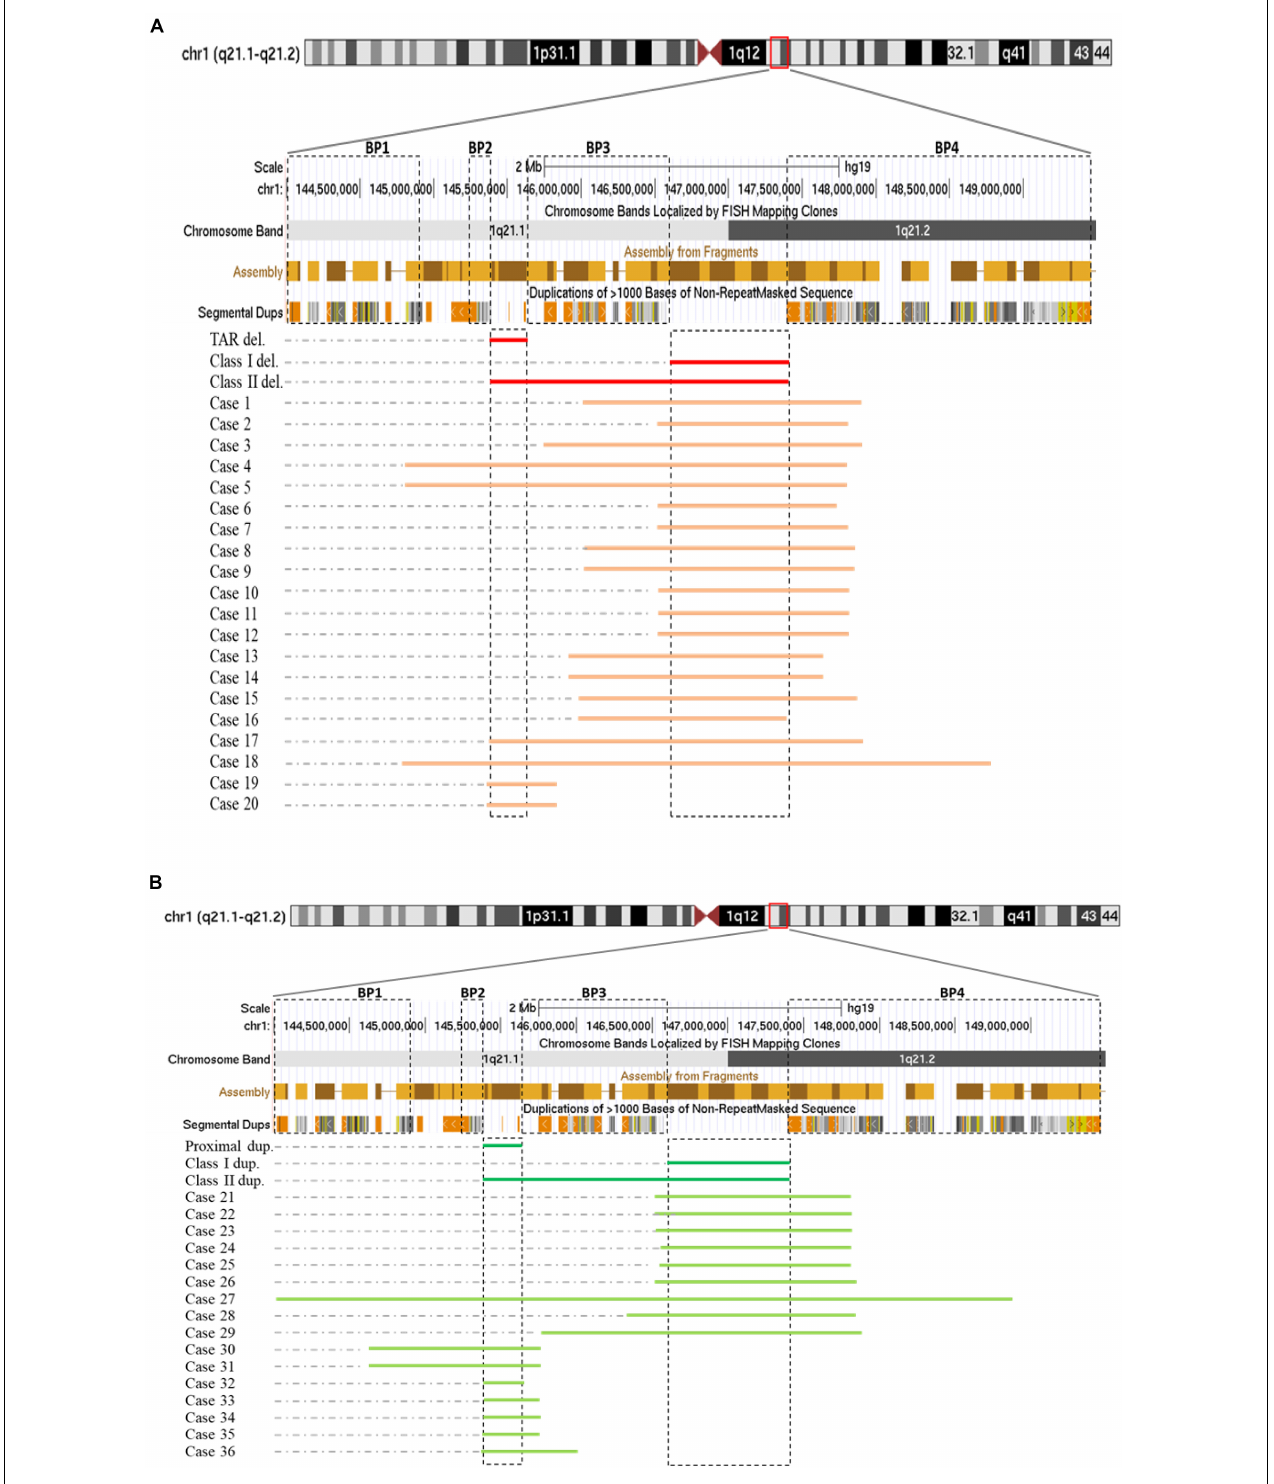
FIGURE 1 | Schematic representations of deletions (A) and duplications (B) at 1q21.1 (GRCh37/hg19, 144.0–149.5 Mb). Breakpoint regions (BP1–BP4) in dotted squares were delineated according to Mefford et al. (2008). Class I, class II, and thrombocytopenia-absent radius (TAR) deletions (labeled as class I del, class II del, and TAR del) were drawn based on Brunetti-Pierri et al. (2008) with modification. In a similar way, class I, class II, and proximal 1q21.1 duplications were generated. We narrowed down the sizes of TAR deletions/proximal 1q21.1 duplications and class I deletions/duplications down to minimal sizes approximately 200 and 800 kb as being reported (Cooper et al., 2011; Albers et al.,